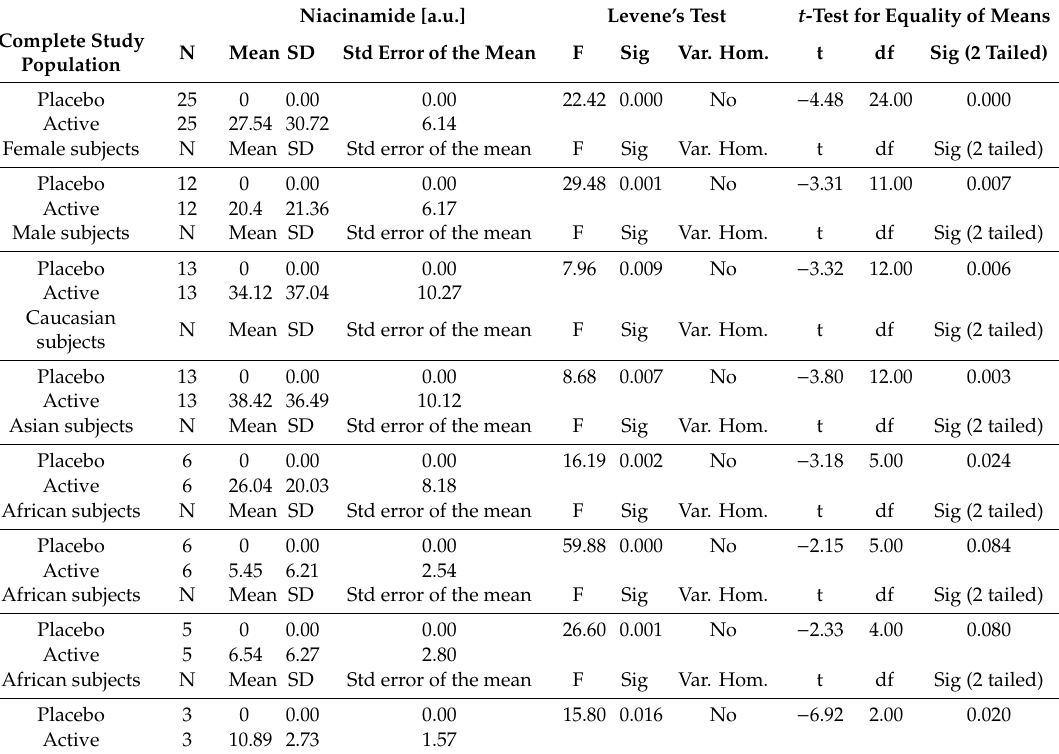
Table 4. Statistical analysis of niacinamide content obtained from volar forearms. Niacinamide